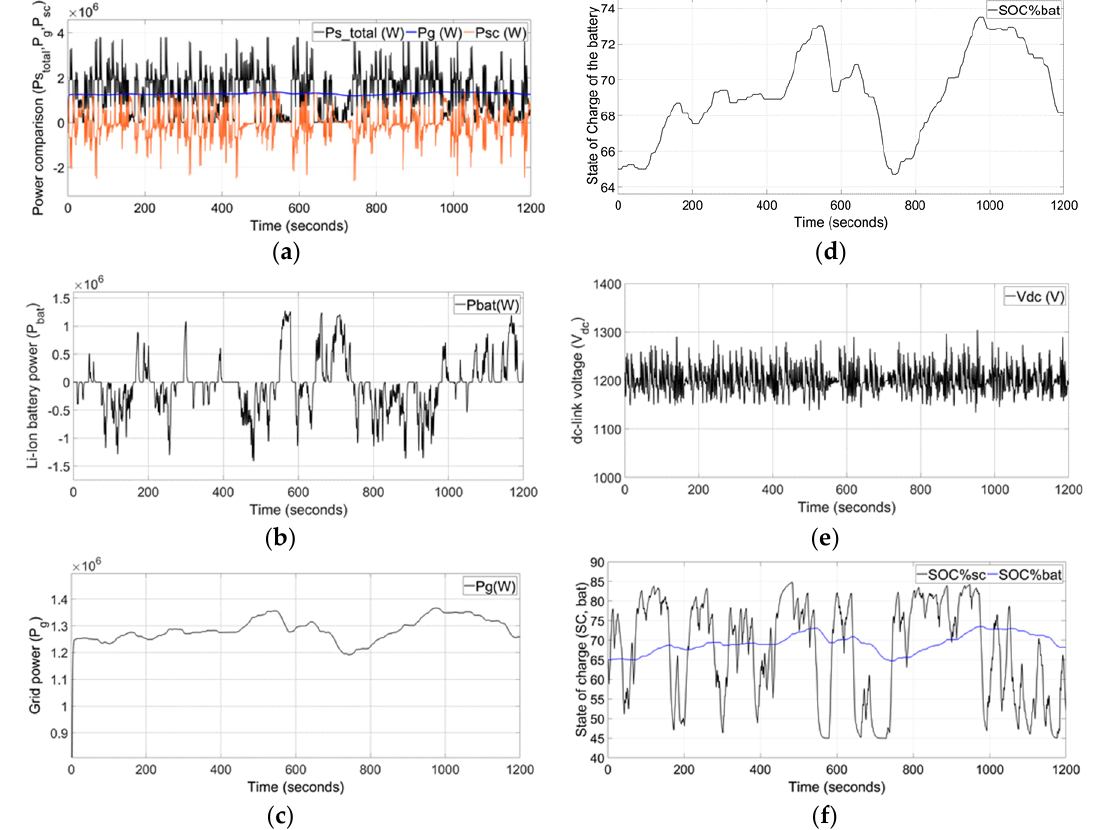
Figure 6. Third case study. ( a ) Power comparison of VOWC generators combined power (P in_total ), grid power (P g ), and supercapacitor power (P sc ), ( b ) Li-ion battery power (P bat ), ( c ) grid power (P g ), ( d ) state of charge of the battery (SOC bat ) ( e ) DC-link Voltage (v dc ), ( f ) state of charge of the supercapacitor (SOC sc ) and battery (SOC bat ).